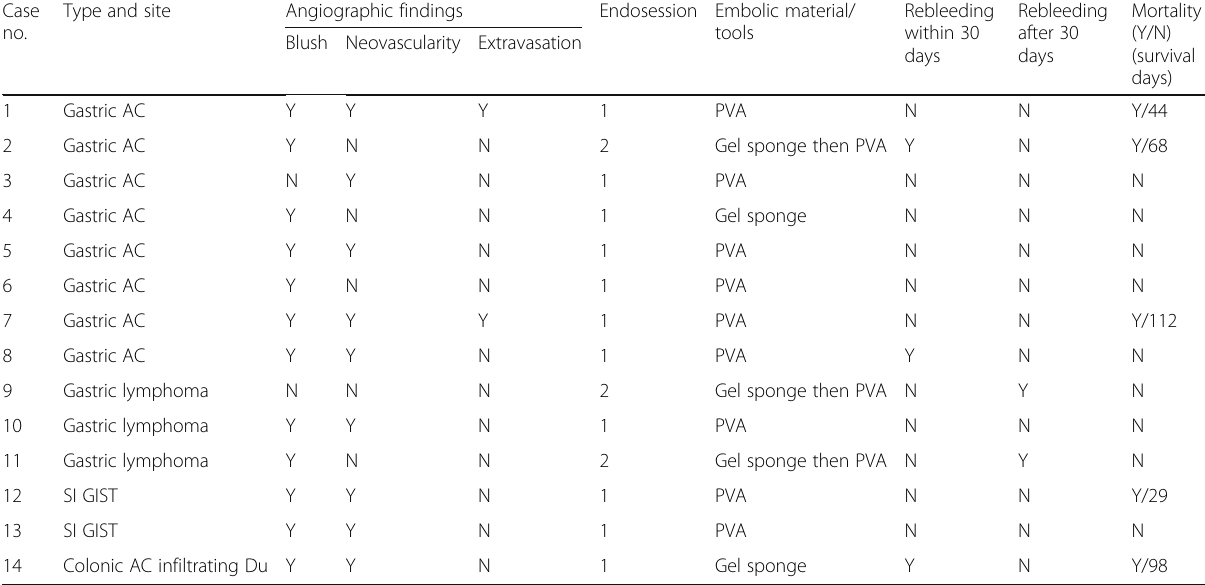
Table 2 Angiographic, procedural, post-procedural follow-up data for each patient Case Type and no.